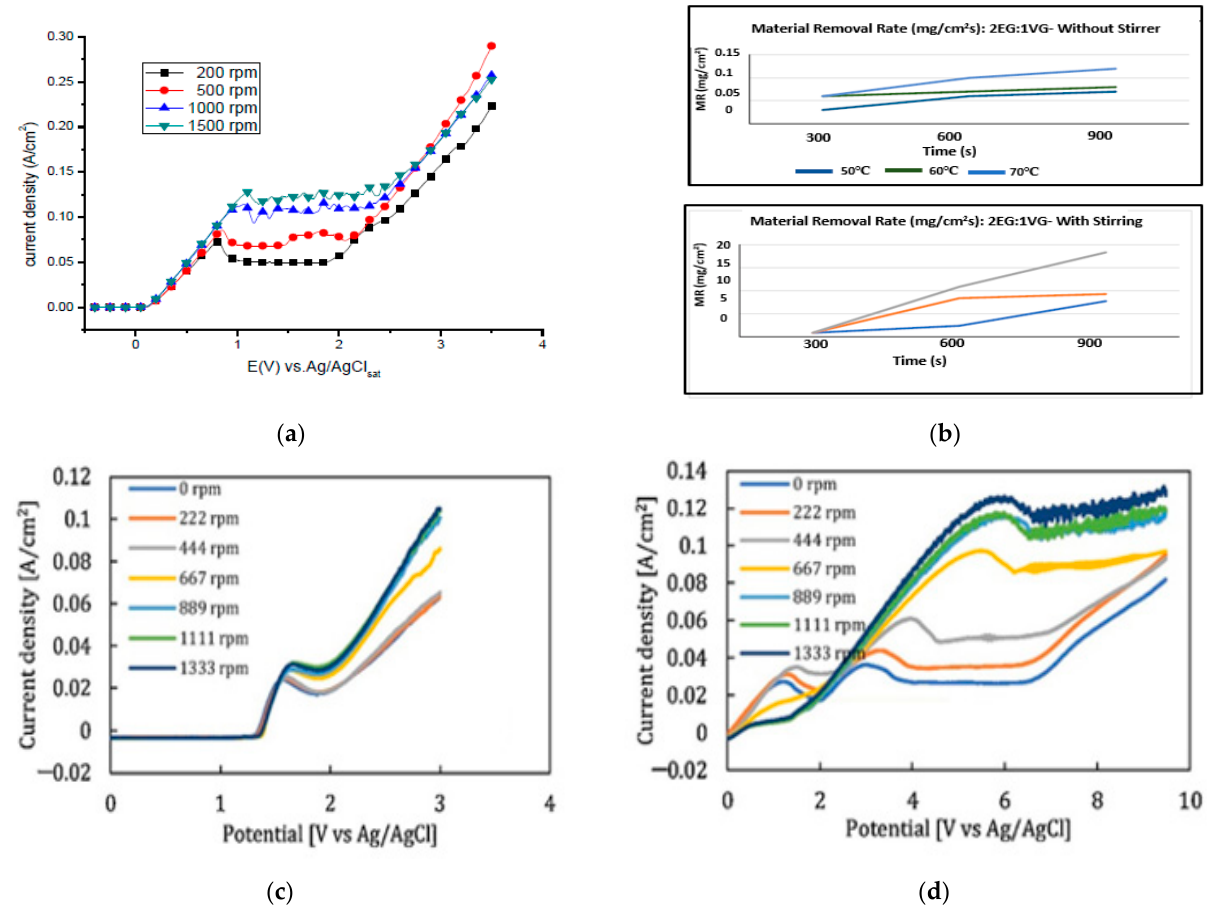
Figure 20. ( a ) The increase in current density with magnetic stirring while electropolishing brass in 70% phosphoric acid [21], (open access article distributed under the terms and conditions of the Creative Commons Attribution (CC BY) license). ( b ) A comparison of material removal rate with and without magnetic stirring in electropolishing of nickel mold inserts in phosphoric acid and ethylene glycol [151], ( c ) Polarization curve for 316SS with magnetic stirring for acidic (H 2 SO 4 -based) and ( d ) green (NaCl-based electrolytes [30]). Note: the different colour lines in ( a ), ( c ) and ( d ) correspond to different stirring speeds, while in ( b ) they correspond to different temperatures.